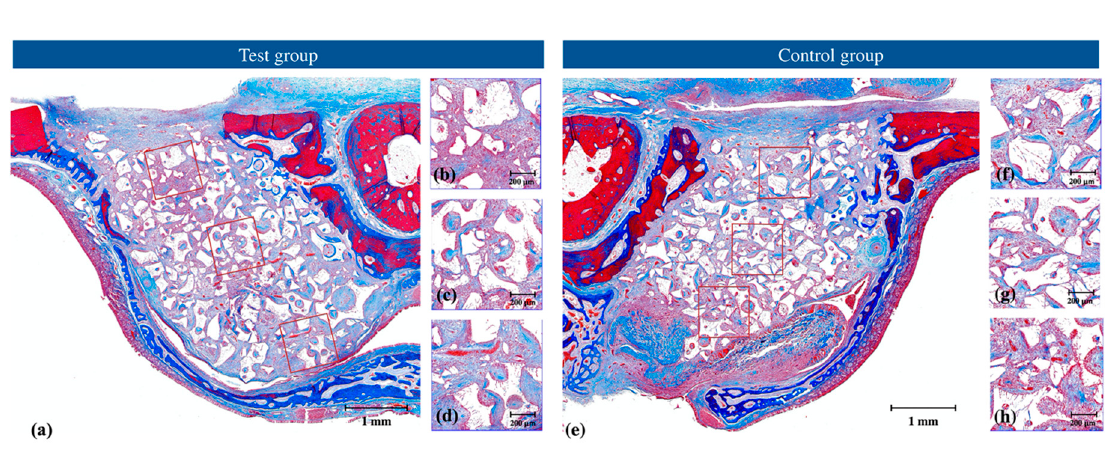
Figure 2. Representative histological views with Masson’s trichrome staining at 2 weeks of the ( a – d ) test and ( e – h ) control groups showing ( a , e ) total augmentation, ( b , f ) region of interest close to the surgical access window, ( c , g ) region of interest at the center of augmentation, and ( d , h ) region of interest close to the Schneiderian